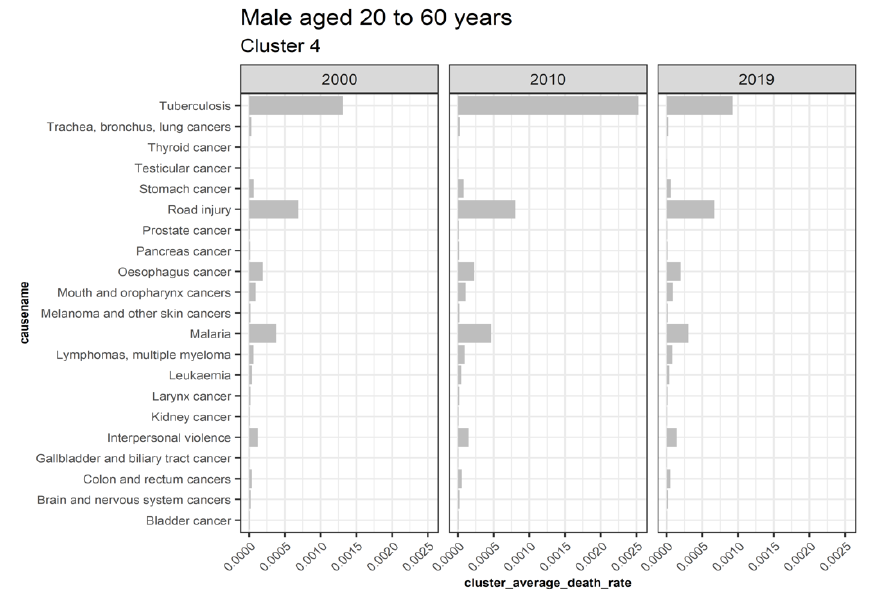
Figure 16. Unlabelled trend causes among younger males in cluster 4 for 2000, 2010, and 2019.